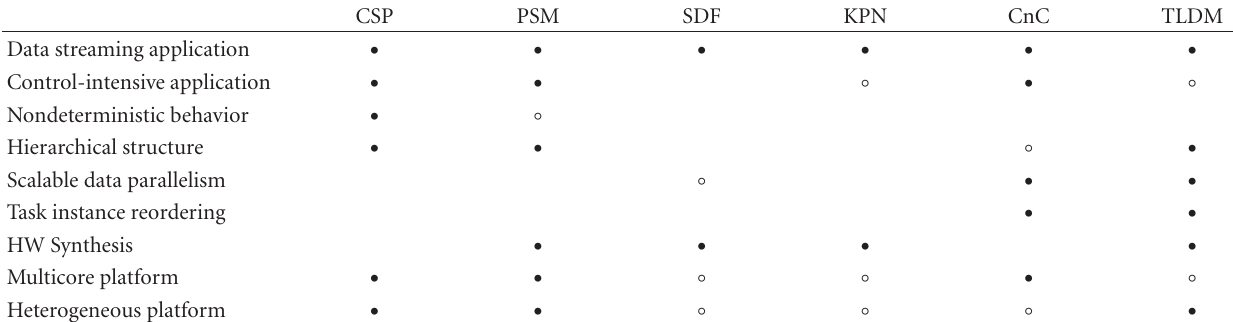
Table 2: Summary of the concurrency